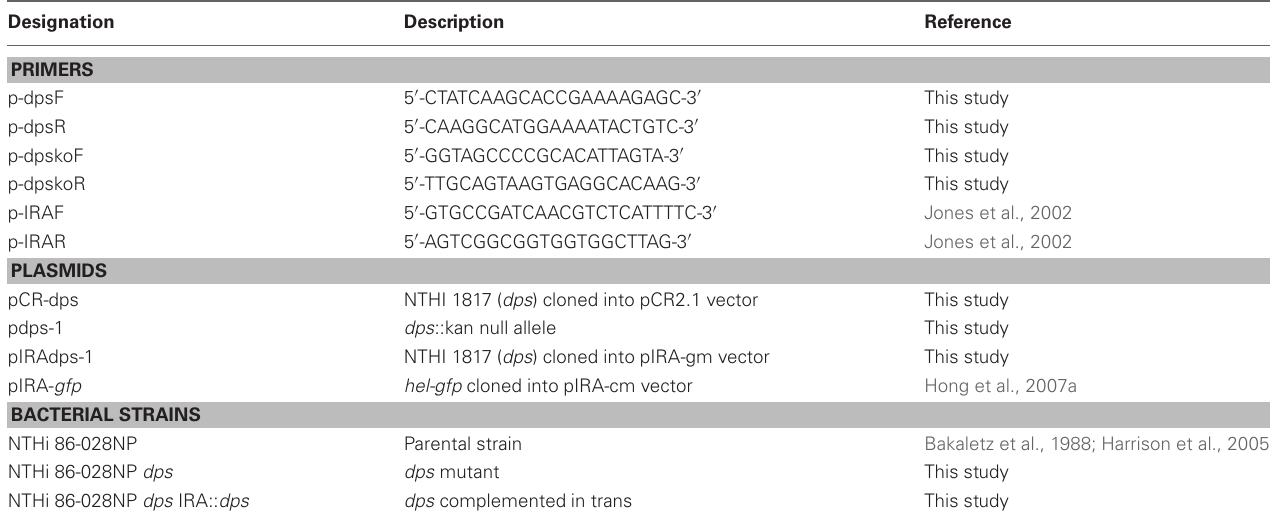
Table 1 | Primers, plasmids, and bacterial strains used in this